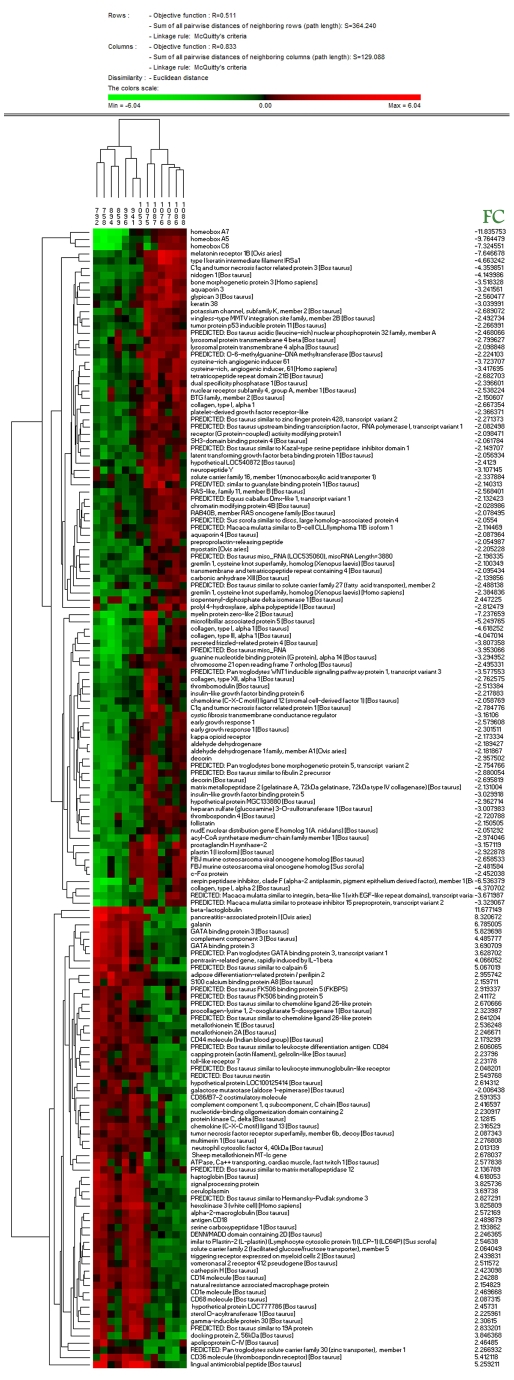
Condition trees of clustering analysis.The hierarchical cluster analysis (Euclidean distance clustering algorithm) was performed using PermutMatrix [100] and 148 genes that differed significantly and had a known function. Each colored bar represents a gene. The color represents the level of expression, and the sample information is listed across the top. The gene names are indicated. Note the distinct patterns of altered gene expression between the positive and control animals.